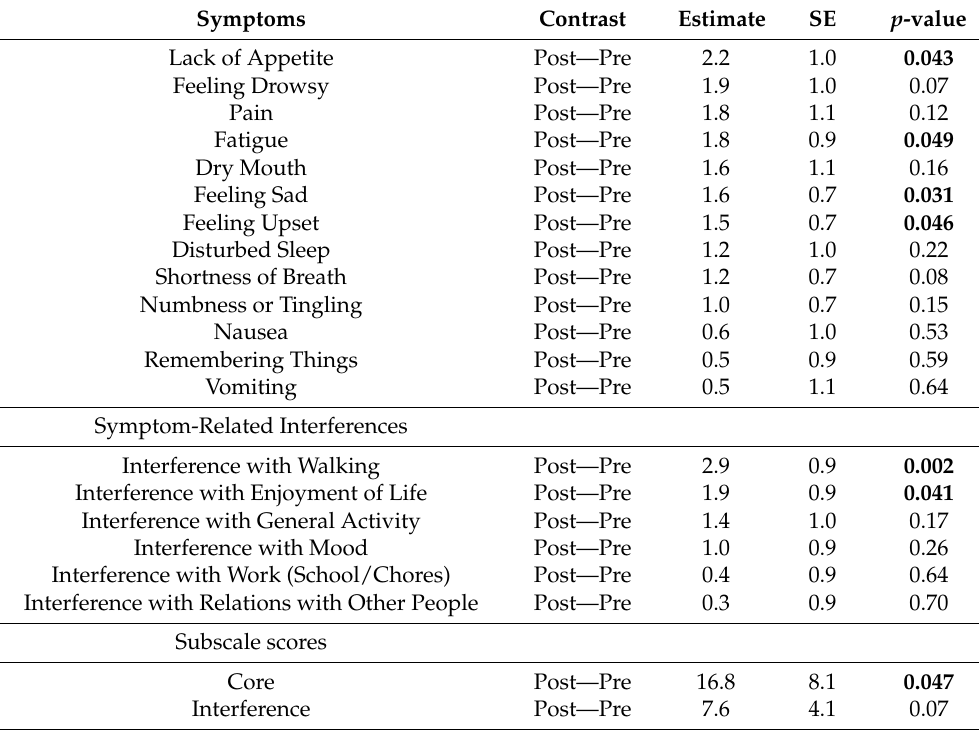
Table 5. Mixed-effect model summaries of change in scores following stem cell transplantation. Scores on the MDASI-Adolescent (MDASI-Adol) before (pre) and after (post) transplant were compared with the difference in scores detailed in the “estimate”